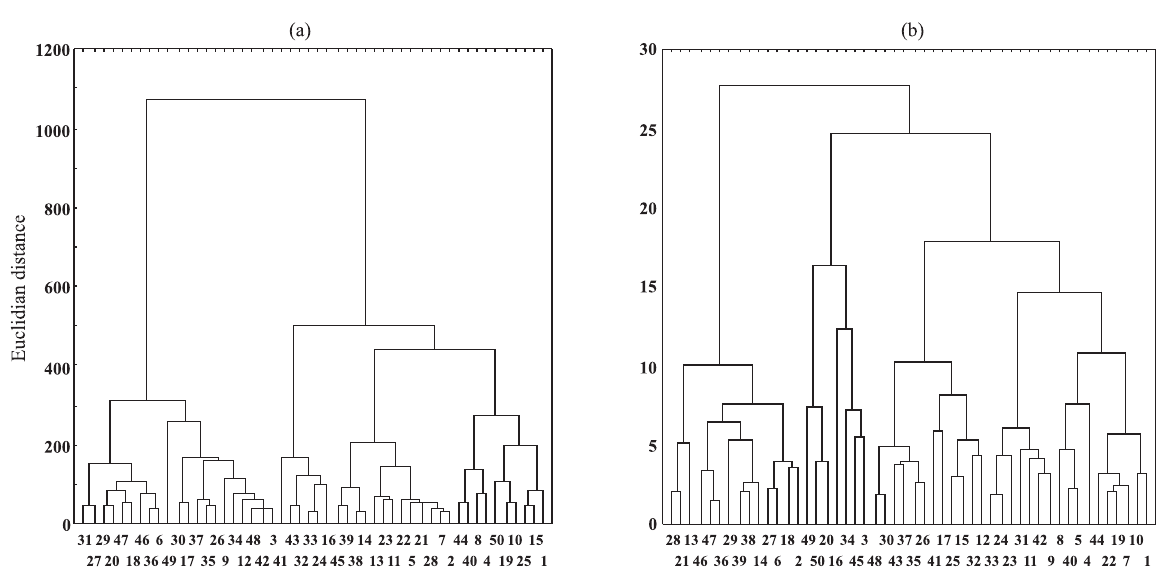
figure 3. dendrogram resulting from cluster analysis of soil properties (a) and the seven main compo- nents (b).